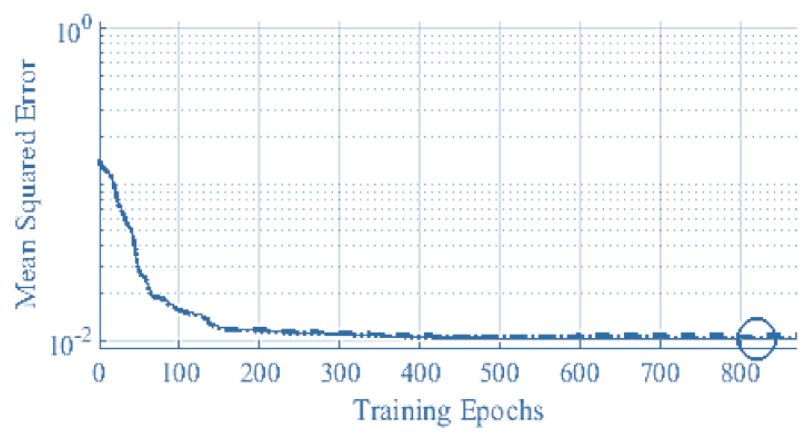
Figure 10. Mean square error performance result for ANN-based classifier training using Levenberg– Marquardt function.